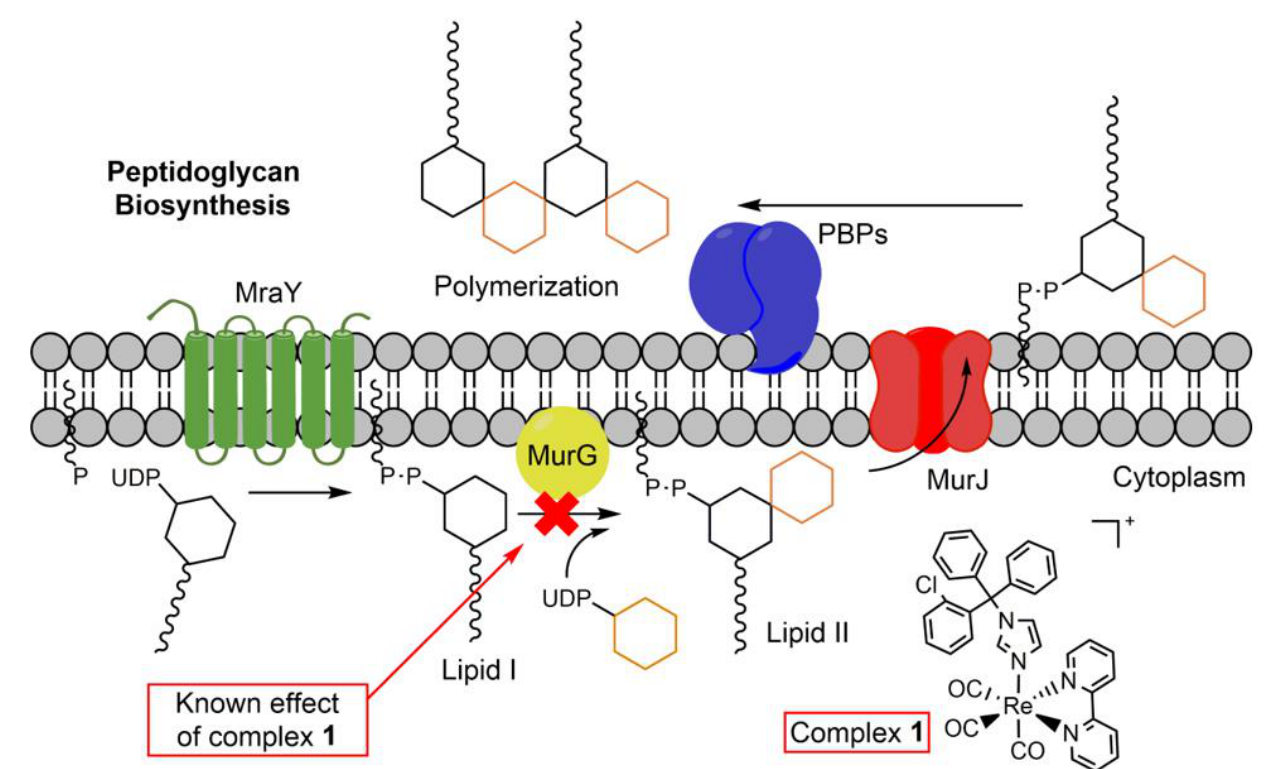
Figure 1. Schematic diagram of the membrane steps of the bacterial peptidoglycan synthesis pathway showing the known inhibitory function of 1 . For more details about the scheme, see [46] .